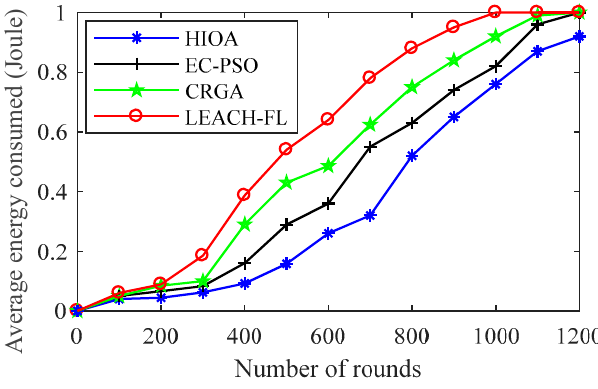
Figure 7. Average energy consumed over round.